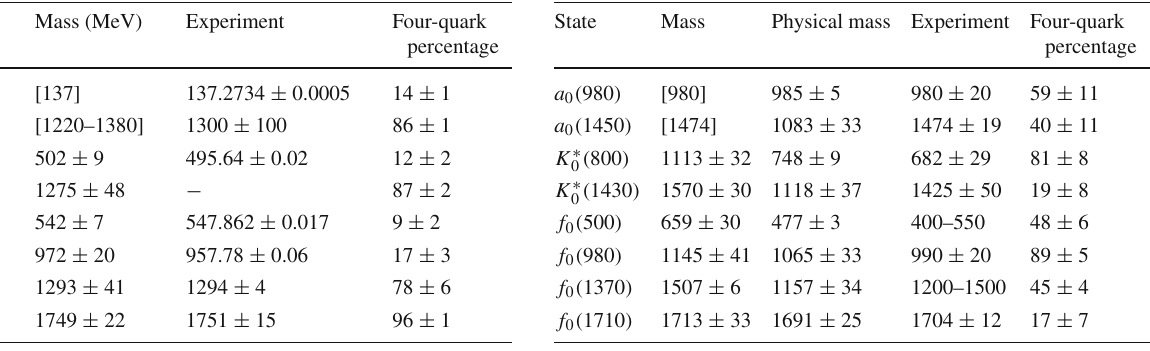
Table 3 Mass and four-quark percentage of the scalar mesons below and above 1 GeV predicted by the leading order of the GLSM [135]. The first column gives the Lagrangian mass (with the exception of those in the square brackets which are taken as inputs, all other values are model predictions). The second column provides the physical mass extracted from the poles of the relevant K-matrix unitarized scattering amplitudes; the third column provides the corresponding experimental values reported in PDG [145]; and the last column gives the estimate of the four-quark content of these states. The model predictions have a range of variation that stem from two of the model inputs with large uncertainties ( m [ π( 1300 ) ] = 1 . 22–1.38 GeV and A 3 / A 1 = 27–30). Each predicted quantity in columns one, two and four is the average of that quantity over its range of variation and its uncertainty is one standard deviation. All displayed masses are in MeV. The predicted properties of states above 1 GeV are expected to improve by inclusion of higher order terms as well as the scalar and pseudoscalar